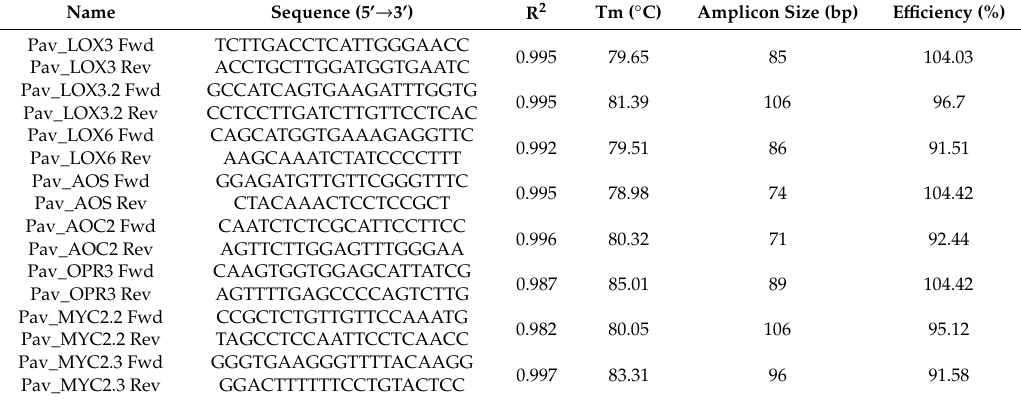
Table 4. List of primers with details of the sequences, amplicon sizes and amplification e ffi